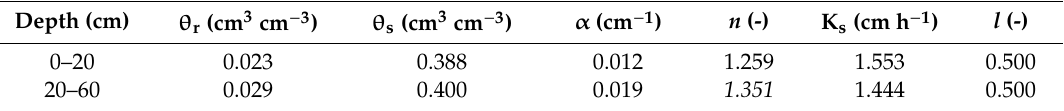
Table 7. Soil hydraulic parameters based on HYPROP + WP4C and further refined by empirical calibration of n .